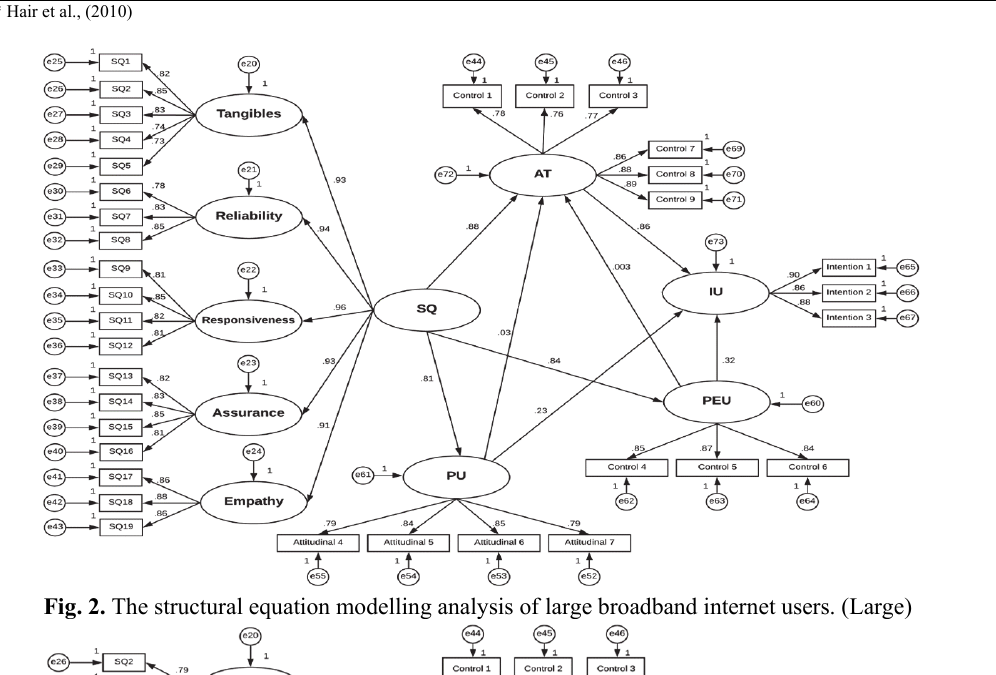
Fig. 2. The structural equation modelling analysis of large broadband internet users. (Large)